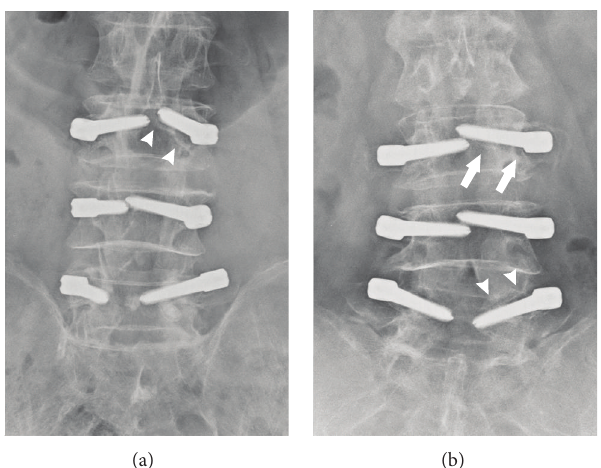
Figure 1: Anteroposterior radiographs. (a) A 61-year-old female who underwent Dynesys stabilization at 12-month postoperation. The double halo sign indicated loosening of the left L3 pedicle screw. (b) A 75-year-old male who underwent Dynesys stabilization, at 2-year postoperation. The double halo sign indicated screw loosening of the left L5 and the halo sign indicated screw loosening of the left L3 screws. Arrowhead, double halo sign; arrow, halo sign.